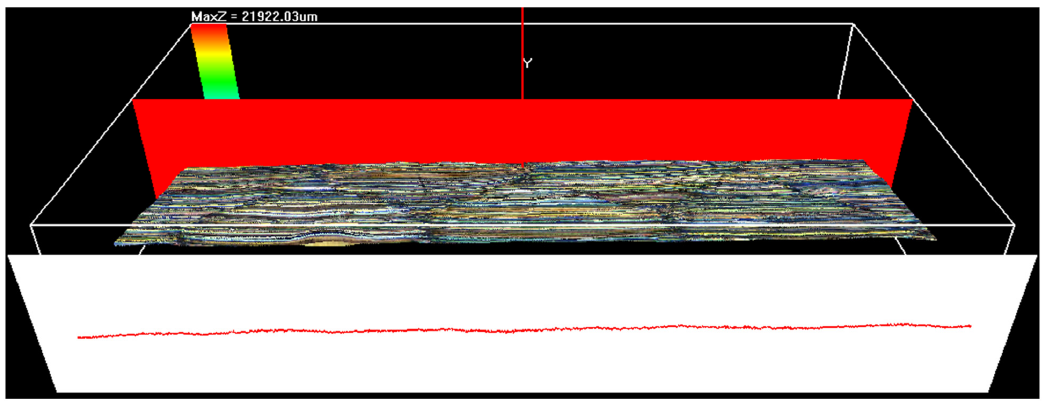
Figure 27. Workpiece surface topography machined by DACT with inclination angle of approximately 20°.